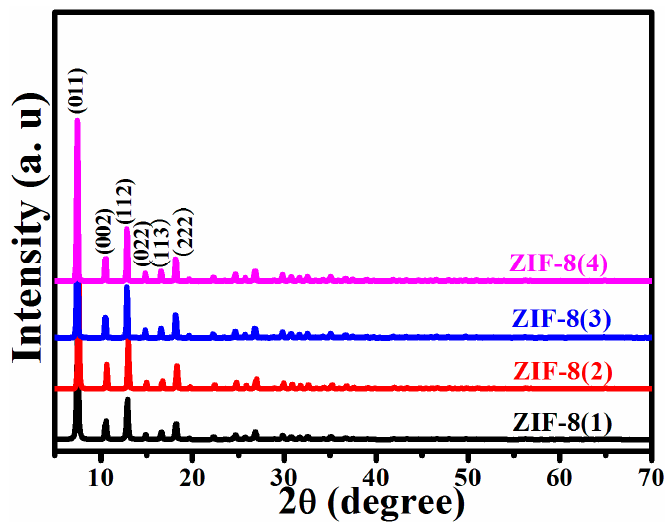
Figure 1. XRD patterns of ZIF-8(1), ZIF-8(2), ZIF-8(3), and ZIF-8(4).